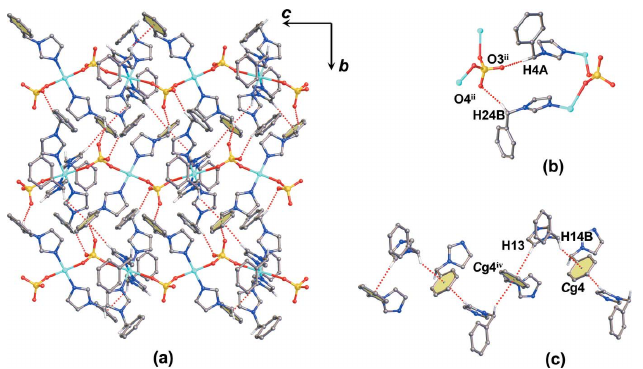
Figure 3 ( a ) View of the two-dimensional supramolecular network of the title compound formed through ( b ) hydrogen bonding-interactions between methylene groups and the sulfate ligand, and ( c ) C—H (cid:2)(cid:2)(cid:2) (cid:3) interactions between adjacent chains. [Symmetry codes: (ii) (cid:5) x + 1, y (cid:5) 1 x , (cid:5) y + 1 , z (cid:5) 1 .] 2 2 bzi imidazole rings to three different oxygen acceptor atoms (O1, O2 and O3) of a sulfate bridging ligand, together with a